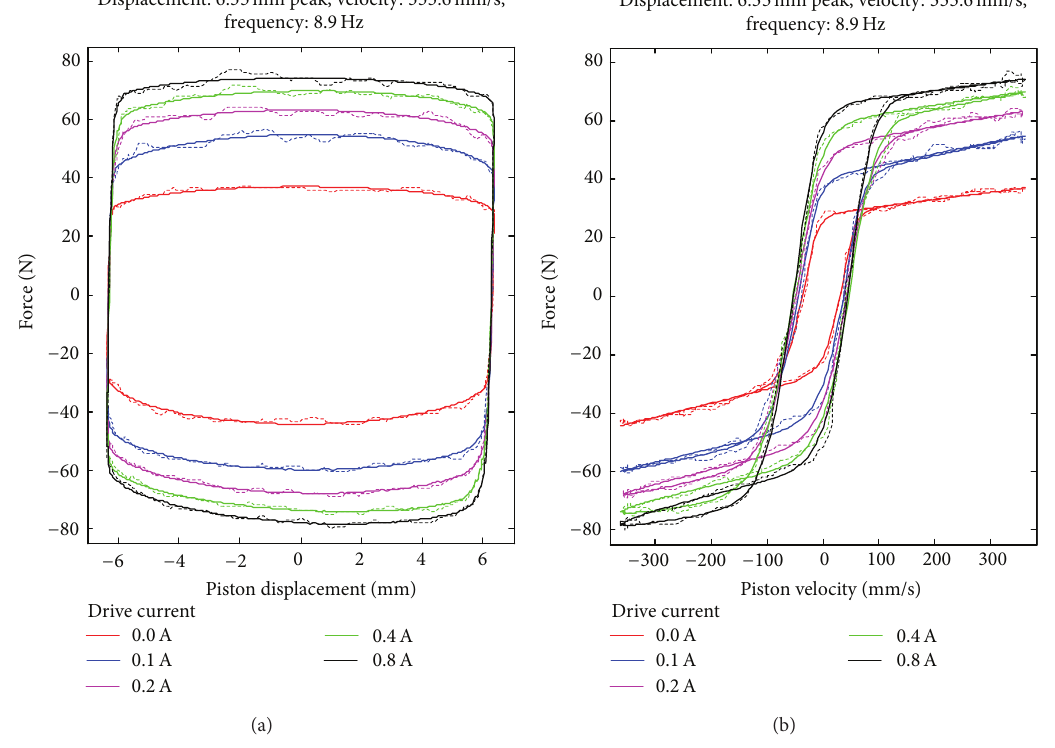
Figure 12: Hysteresis curves comparison at different drive current. Tested data (- - -) and reconstructed results from identified parameters (—): (a) force versus displacement hysteresis curves and (b) force versus velocity hysteresis